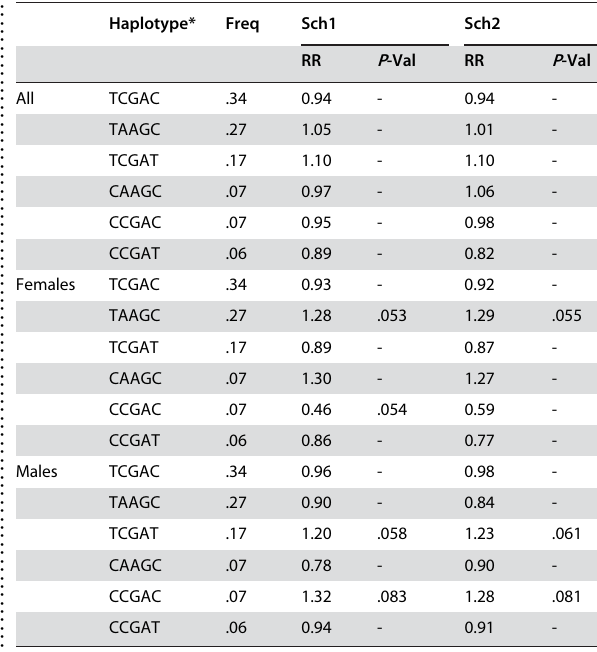
Table 4. LAMP results for haplotype analysis (frequency . .05) ... ... ... .... ... ... .... ... ... .... ... ... .... ... ... .... ... ... .... ... ...